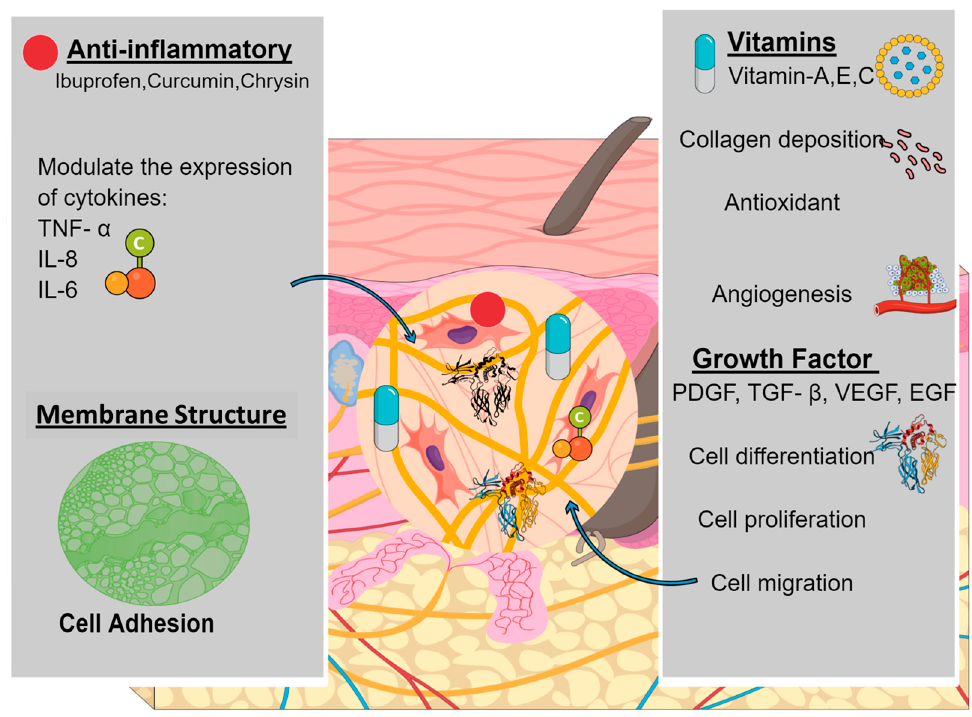
Figure 4. Represents the various bioactive molecules impregnated into nanofibrous scaffolds and their function in wound-healing process.